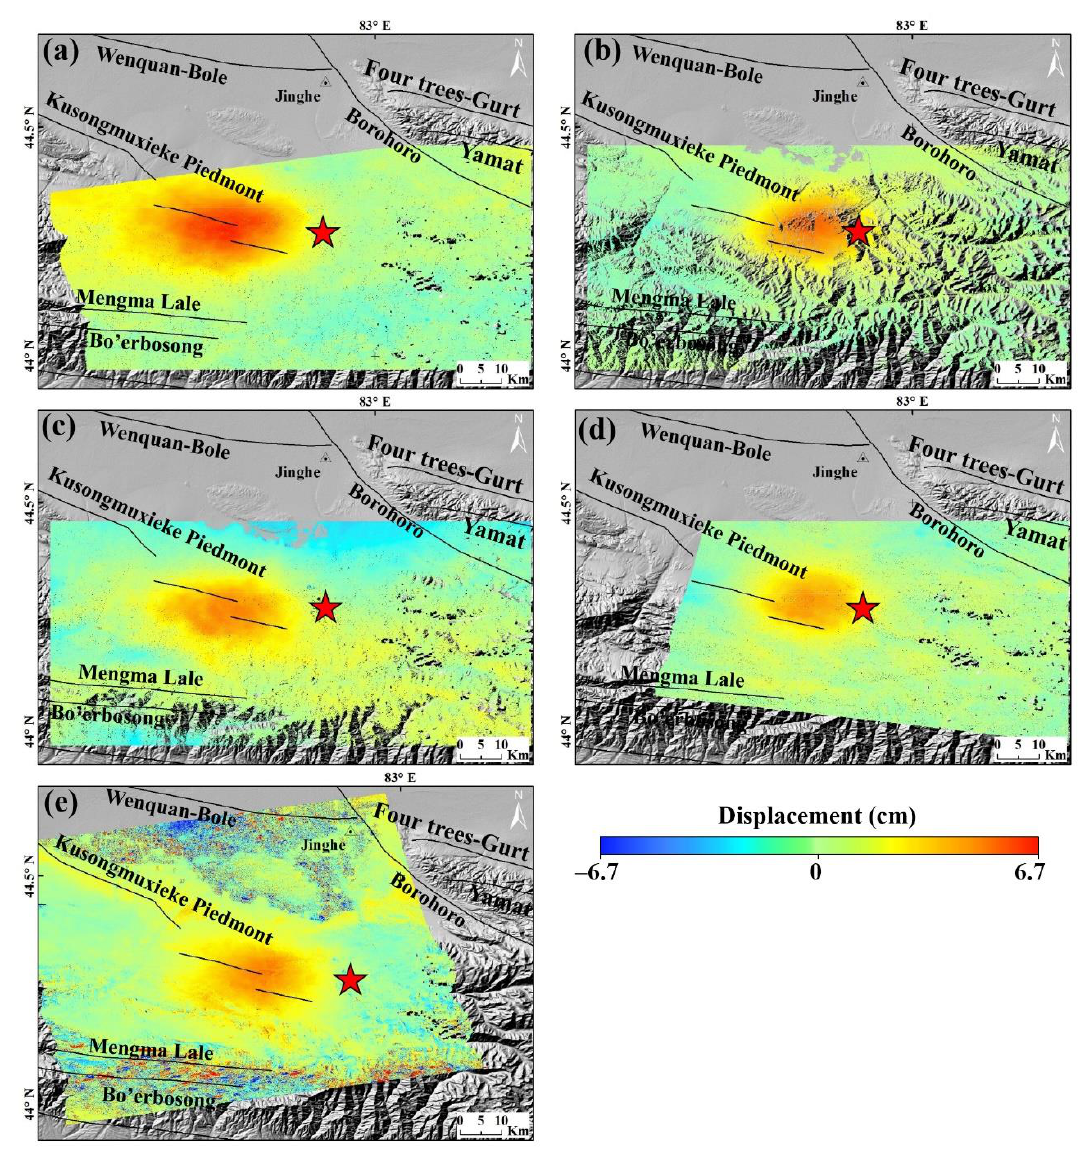
Figure 4. Reconstructed maps of coseismic displacement in a line-of-sight (LoS) direction. Color scale is from − 6.7 to 6.7 cm, and the positive values indicate the movements towards the satellite sensor. ( a ) Sentinel-1 T12; ( b ) Sentinel-1 T63; ( c ) Sentinel-1 T85; ( d ) Sentinle-1 T165; ( e ) Advanced Land Observing Satellite 2 (ALOS2) ascending interferogram. Table 2. Parameters of the estimated displacement maps from Sentinel 1 and PALSAR2 1 . Single Single Averaged Track- Satellite Pair Min. Pair Max. Disp. SD. Orbit 2 SD (cm)